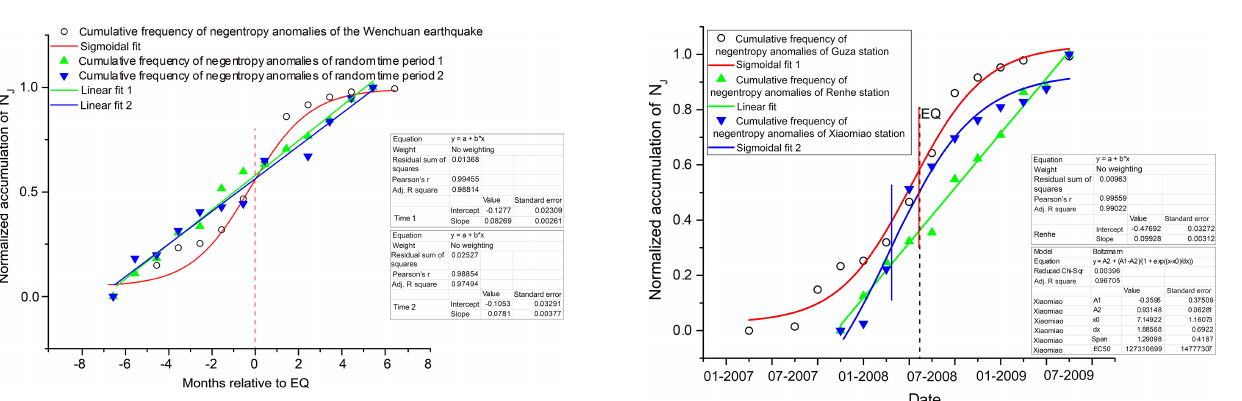
Figure 10. Cumulative frequency of negentropy anomalies of Xi- aomiao station and Renhe station from 16 September 2007 to 30 June 2009. The negentropy analysis of Guza station is from 1 January 2007 to 30 June 2009 because of the different installa- tion time of the instruments. The red vertical line is the inflection point of the fitting curve of Guza station. The blue vertical line is the inflection point of the fitting curve of Xiaomiao station. The black dotted line is the earthquake